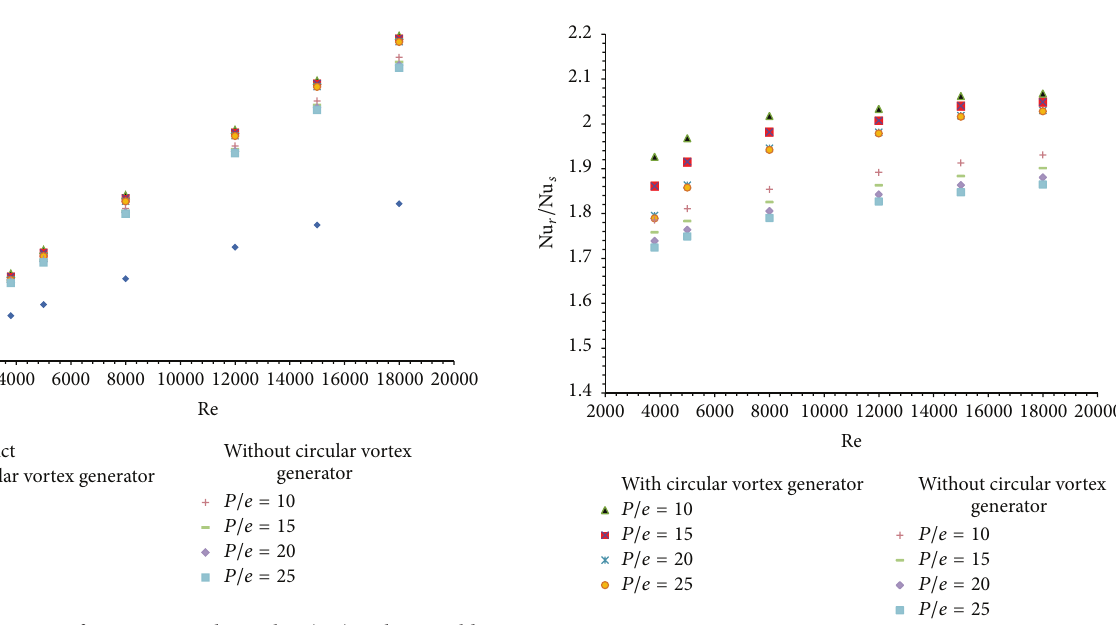
Figure 6: Variation of average Nusselt number (Nu) with Reynolds number (Re). Figure 7: Variation of average Nusselt number enhancement ratio (Nu 𝑟 / Nu 𝑠 ) with Reynolds number